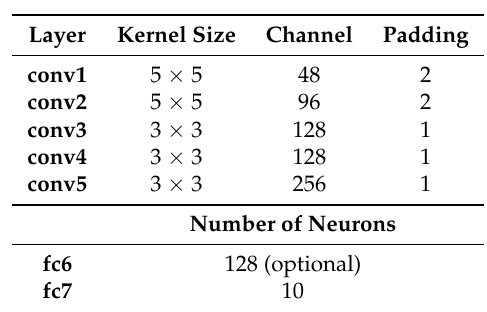
Table 1. Design scheme of classification